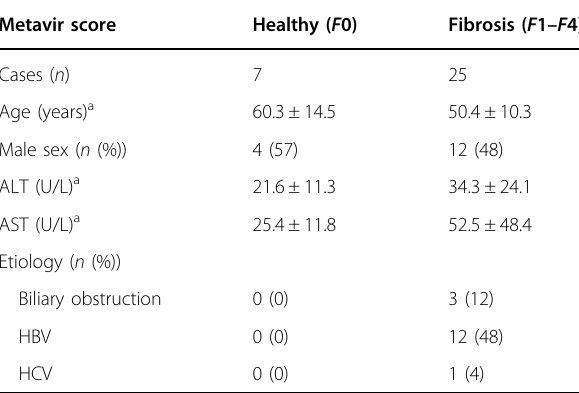
Statistical analysis Data were expressed as mean ± SD. All the statistical analyses were performed with the SPSS 13.0 (IBM, Armonk, NY, USA). Statistical analyses were performed using either Student ’ s t test (two-group comparison) or one-way analysis of variance (more than two groups) followed by post hoc comparison, and differences with p < 0.05 were considered signi fi cantly.